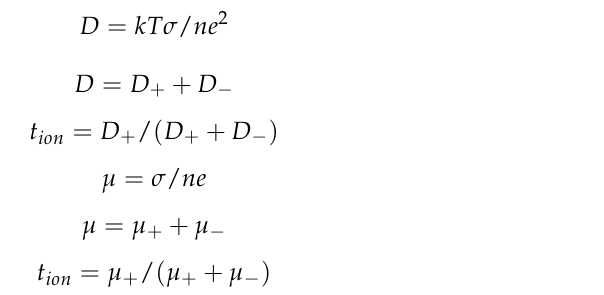
Figure 9. LSV for the highest plasticized sample (PSP_2) at RT.